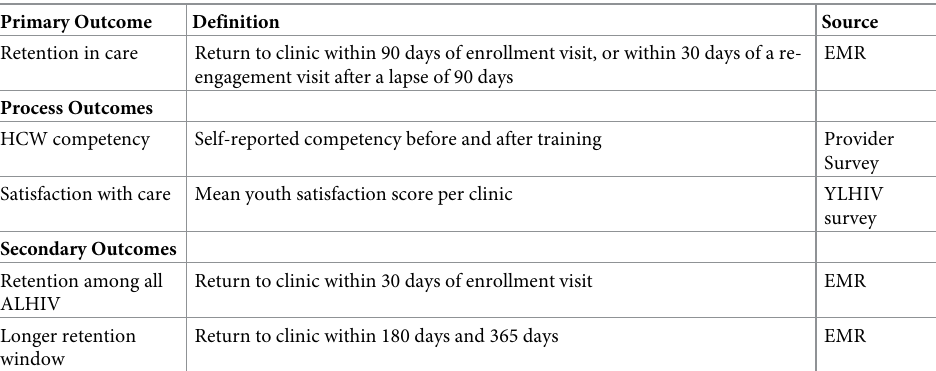
Table 2. Study outcomes, definitions, and